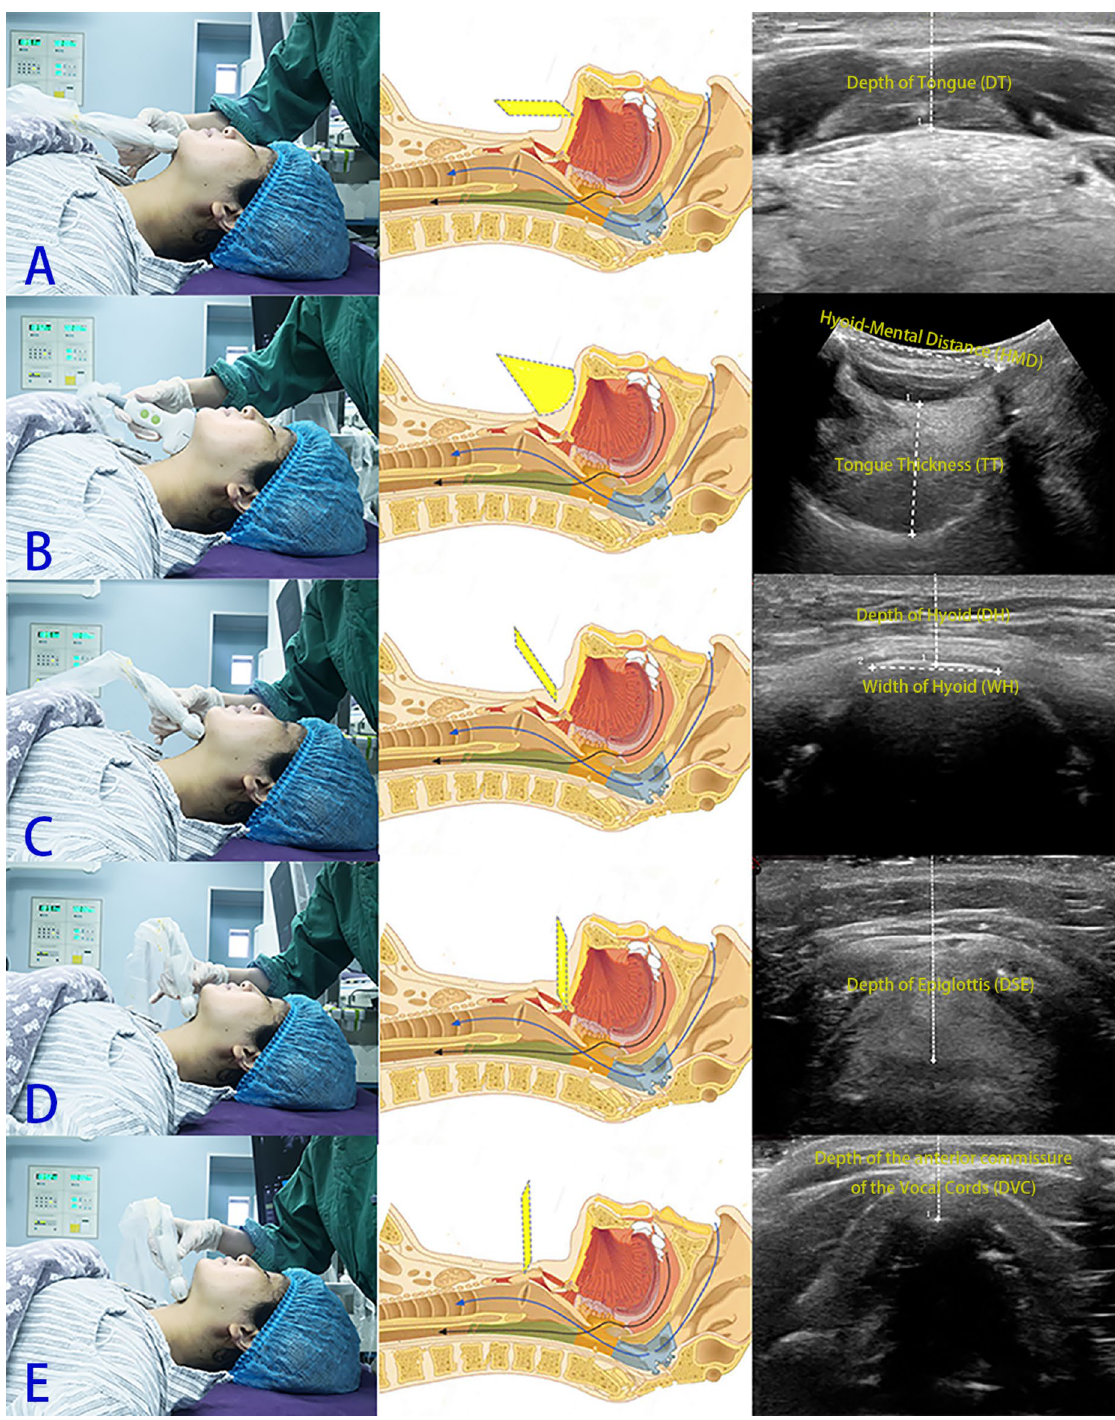
Figure 1. Patient positioning and transducer placement for measuring (left), anatomical (middle) and ultrasonography views (right) at the level of the tongue surface ( A ), tongue body ( B ), hyoid ( C ), epiglottis ( D ) and vocal cords ( E ), before anaesthetic induction. Consent to publish the figure was obtained from the